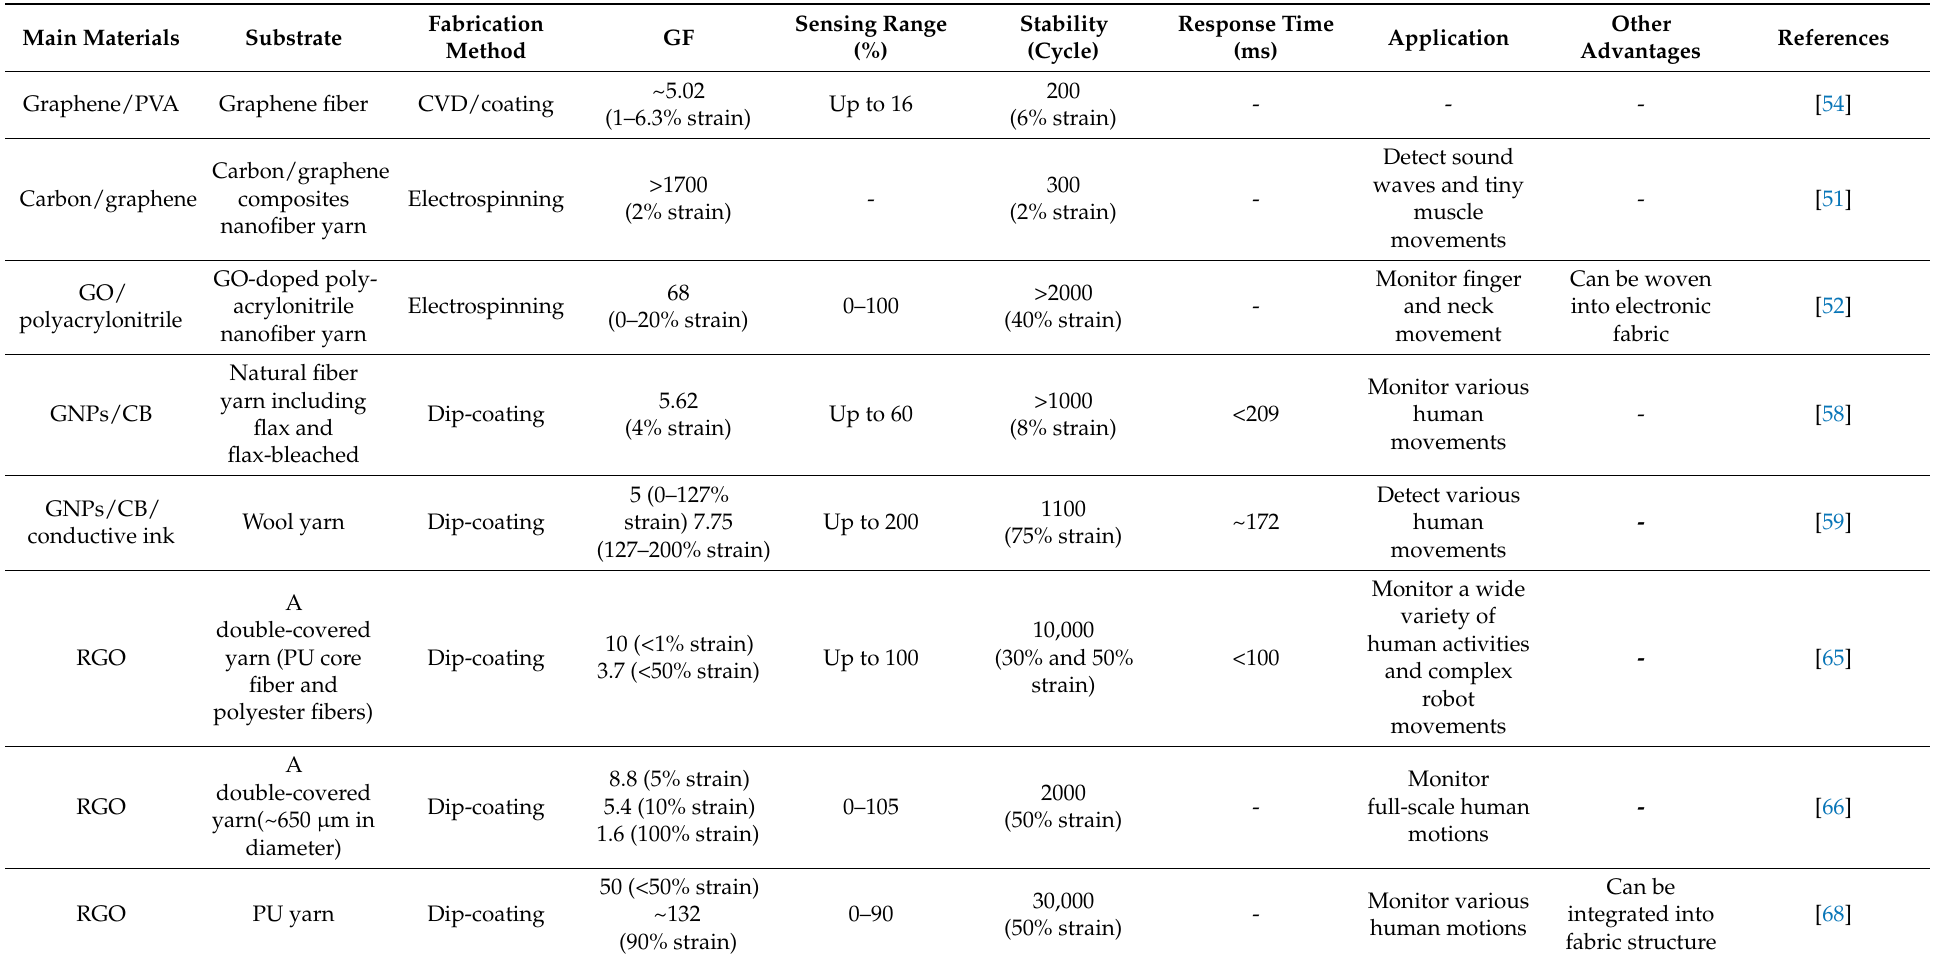
Table 2. Properties of various graphene-based staple and filament yarn strain